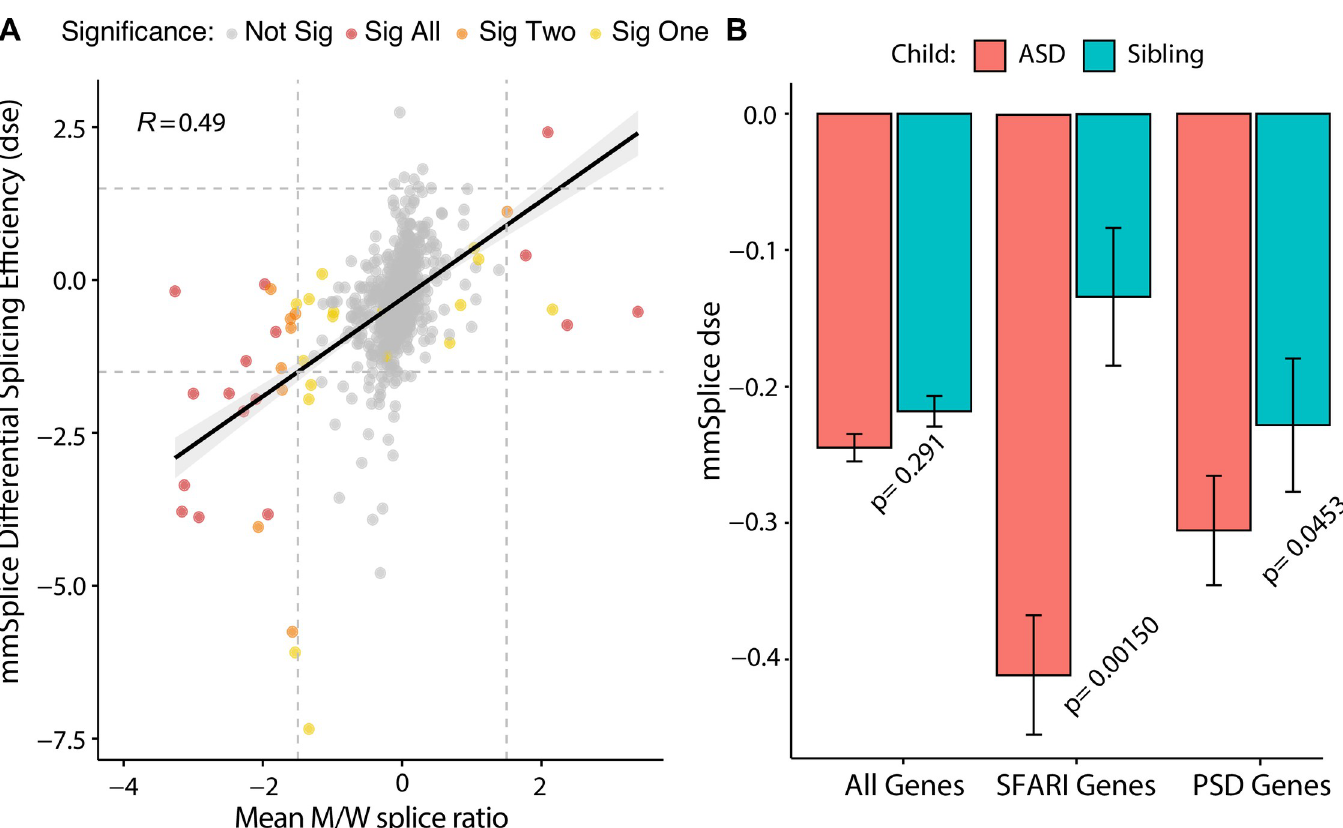
Fig 4. Splicing predictions reveal PSD gene de novo variants in ASD probands commonly disrupt splicing. Relationship of mmSplice predicted differential splicing efficiency (dse) to experimentally determined allelic imbalance. Dashed lines represent 1.5-fold change cutoffs for calling a significant splicing defect. Labels indicate constructs where significance was established for each variant. B. Left, mean mmSplice predicted dse of de novo coding variants associated in all genes (left), SFARI category 1–5 genes (middle), and post-synaptic density protein genes (right) in ASD children (red) vs unaffected siblings (teal). ( p -values represent Mann-Whitney U test and error bar represent